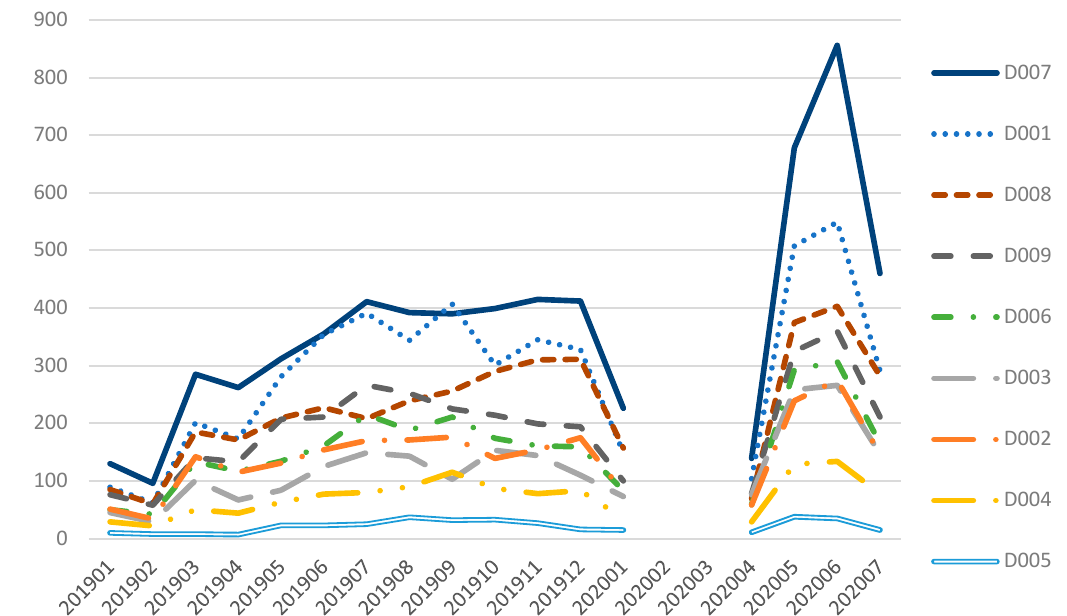
Figure 2. Numbers of Sales by Districts of Wuhan. Source: HomeLink 2020; Notes: Total numbers of housing units transacted in the nine districts from January 2019 to July 2020. The transaction data in February and March is not available due to the city lockdown.